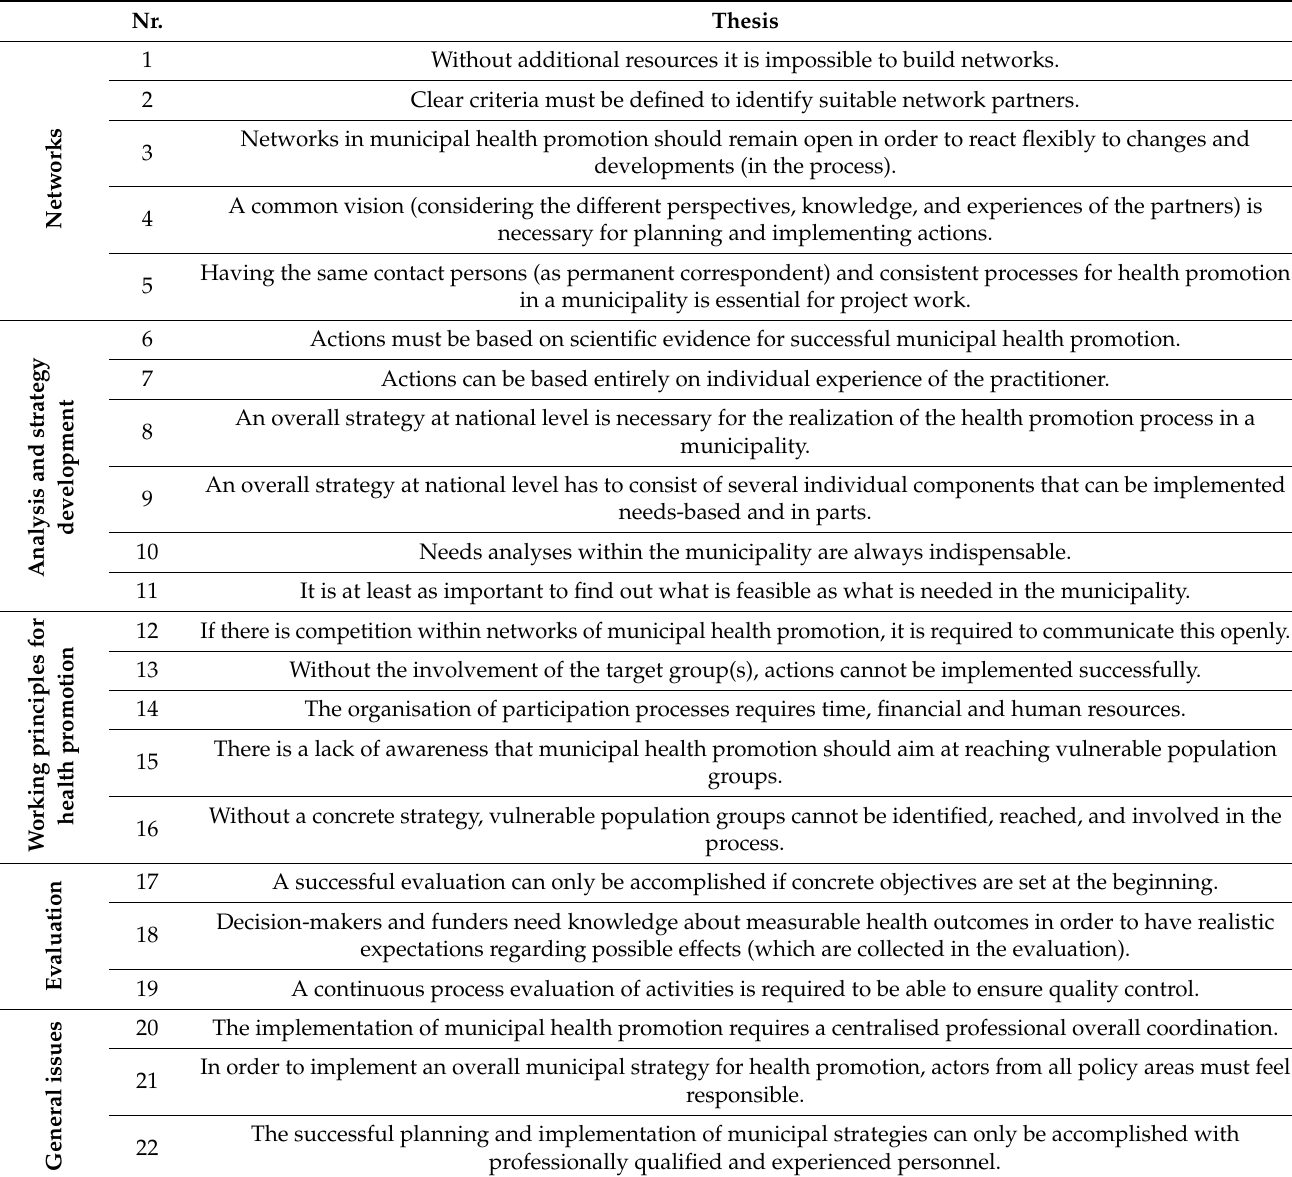
Table 1. Overview of the theses included in the Delphi